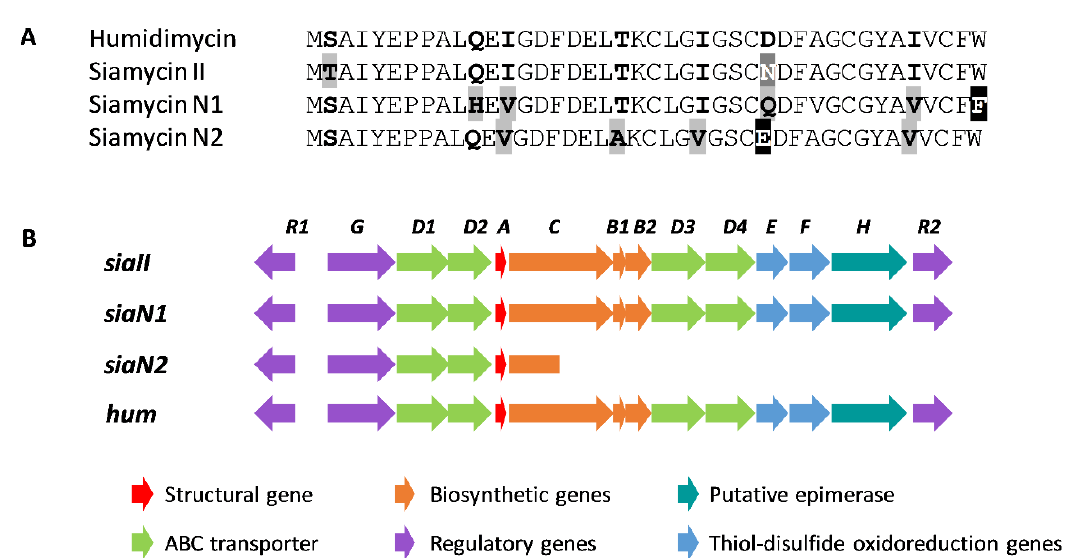
Figure 7. Comparison of the pre-propeptide sequences ( A ) and the biosynthetic gene cluster (BGC) ( B ) of humidimycin, siamycin II, and the new siamycins (N1 and N2) identified by genome mining.